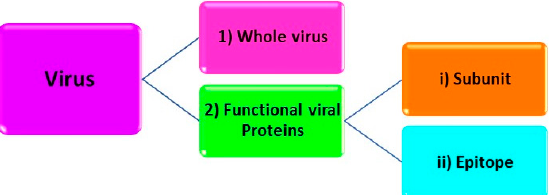
Figure 3. Schematic representation of structural levels of target analyte in the virus imprinting pro- cess.